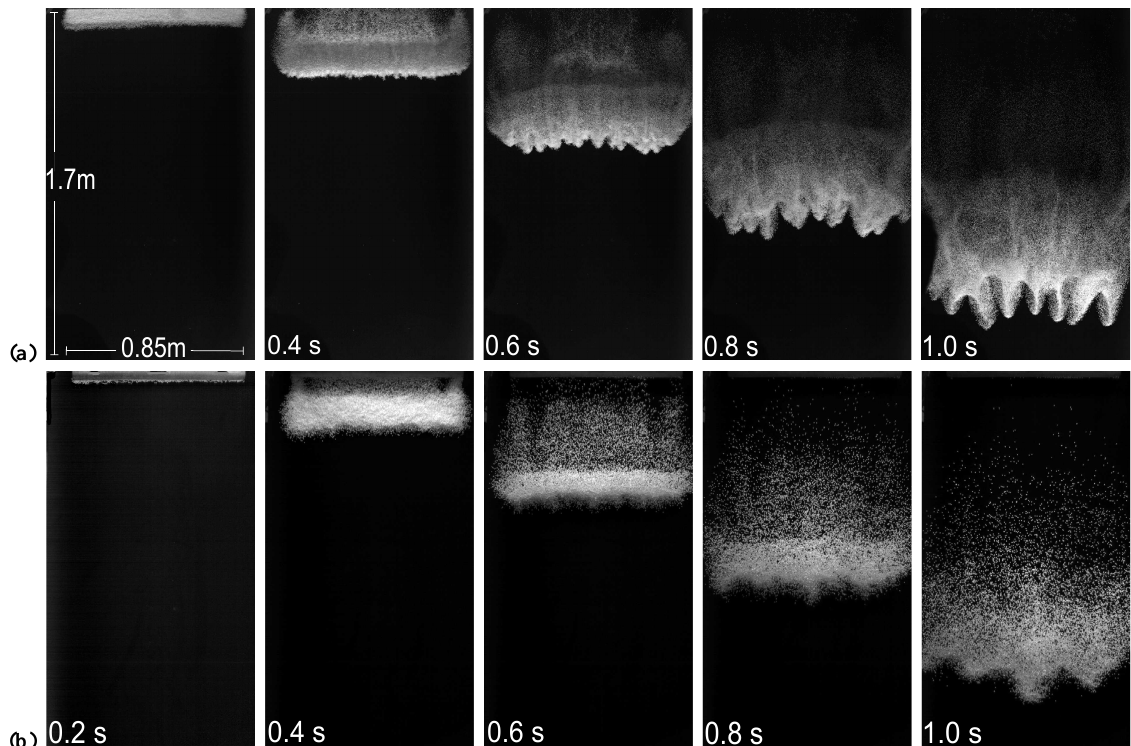
Fig. 3. Video stills taken at 0.2s intervals from experiments conducted at a slope angle of 65 ◦ using: (a) 2100cm 3 of 1.8mm diameter EPS beads and (b) 3300cm 3 of 5.0mm diameter EPS